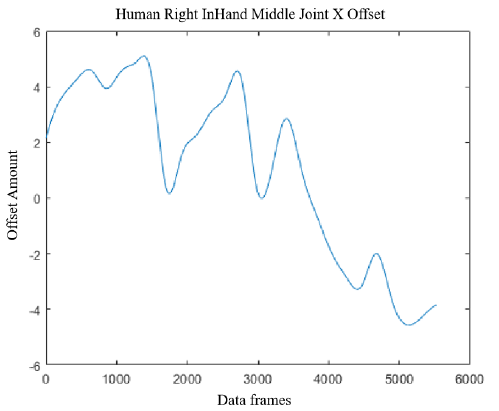
Figure 13. Human right-hand middle joint x